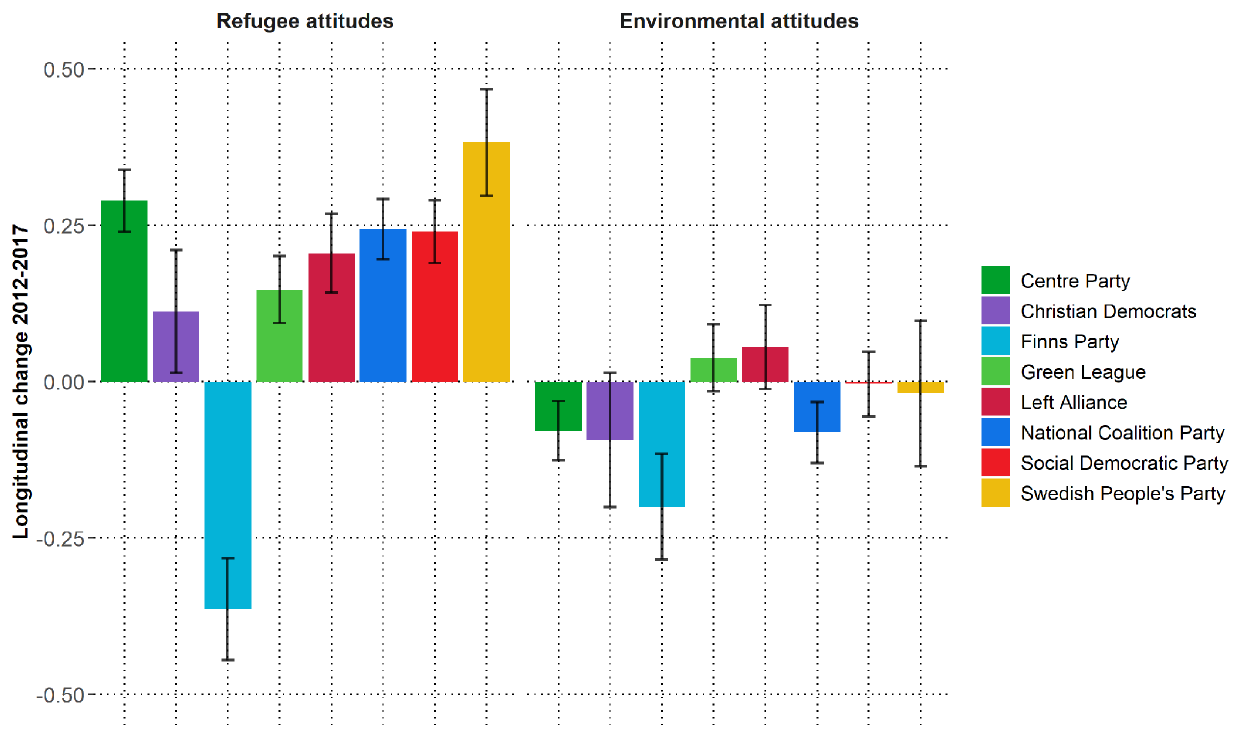
Figure 2. Longitudinal change 2012-2017 in refugee and environmental